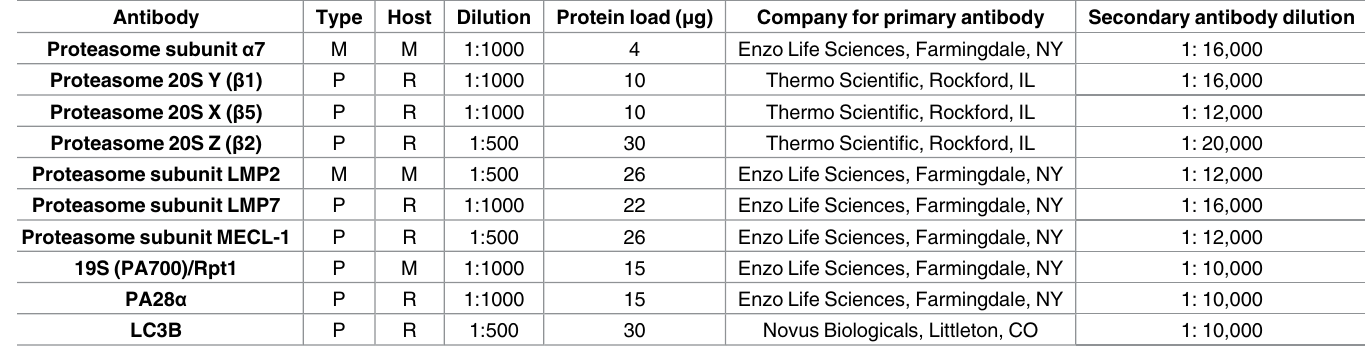
Table 1. Antibodies used for Western blotting.